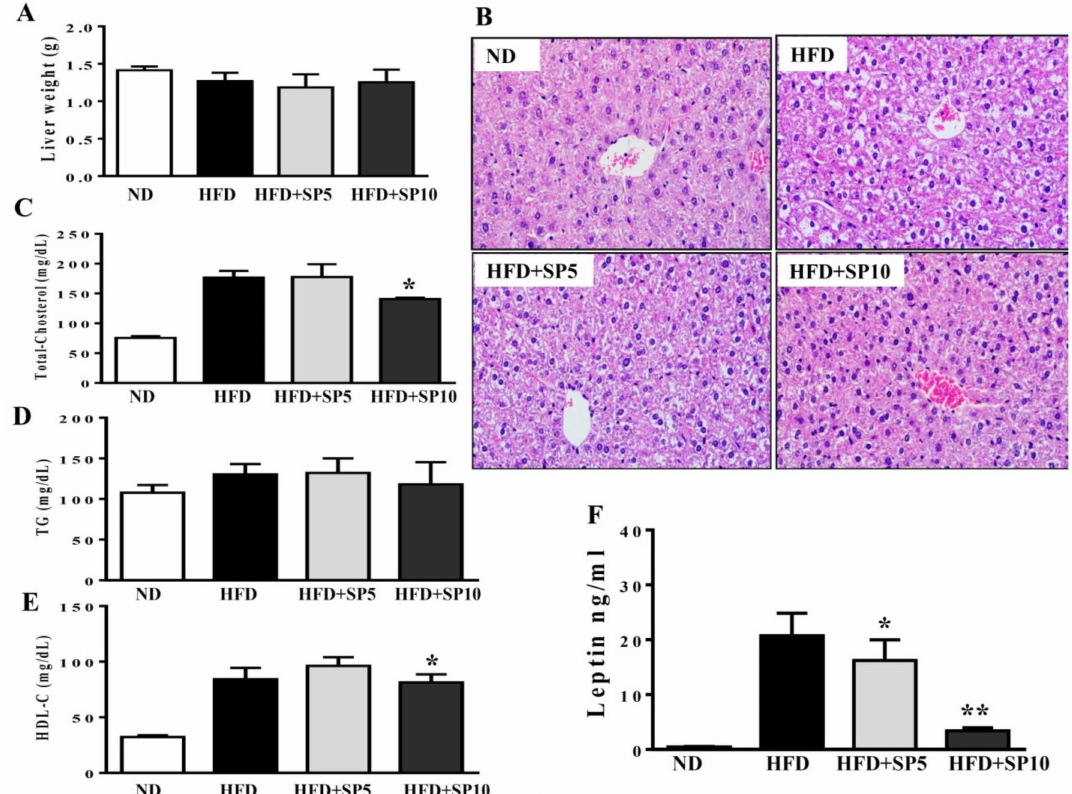
Figure 7. Spilanthol (SP) ameliorates hepatic steatosis, decreases serum leptin levels, and improves serum biochemical parameters in HFD-induced obese mice. ( A ) Final liver weight. ( B )